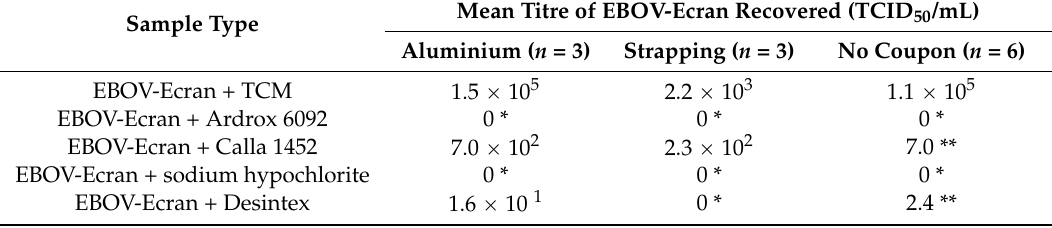
Table 2. Recovery of EBOV-Ecran recovered from different test surfaces after treatment with four disinfectants.